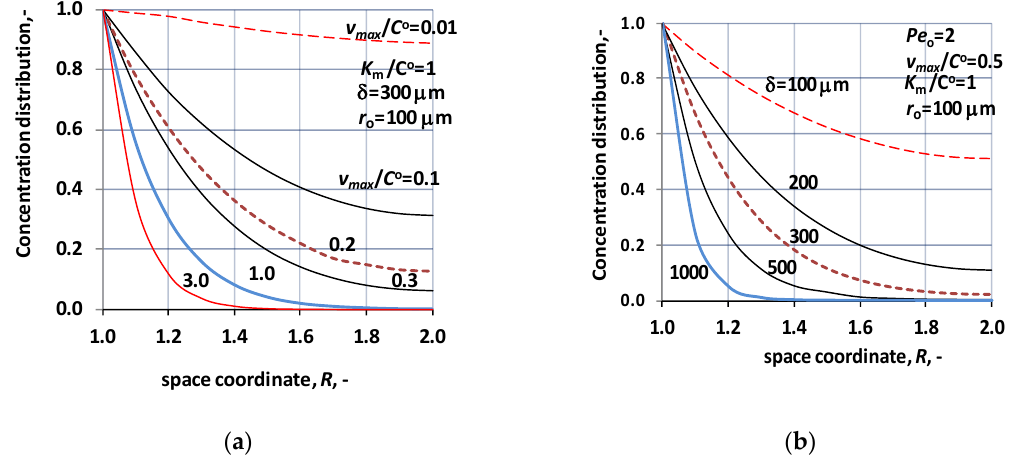
Figure 2. Normalized concentration distribution across the biocatalytic membrane layer, in case of mass transport without sweeping phase. ( a ) The parameter is the relative value of the maximal reaction rate, i.e., v max /C O ( Pe o = 2; D = 1.9 × 10 −9 m 2 /s; r o = 100 μm; δ = 300 μm; K M /C O = 1); ( b ) concentration distribution at different values of the thickness of the biocatalytic membrane layer ( Pe o = 2; D = 1.9 × 10 − 9 m 2 /s; r o = 100 μm; K M / C O = 1).